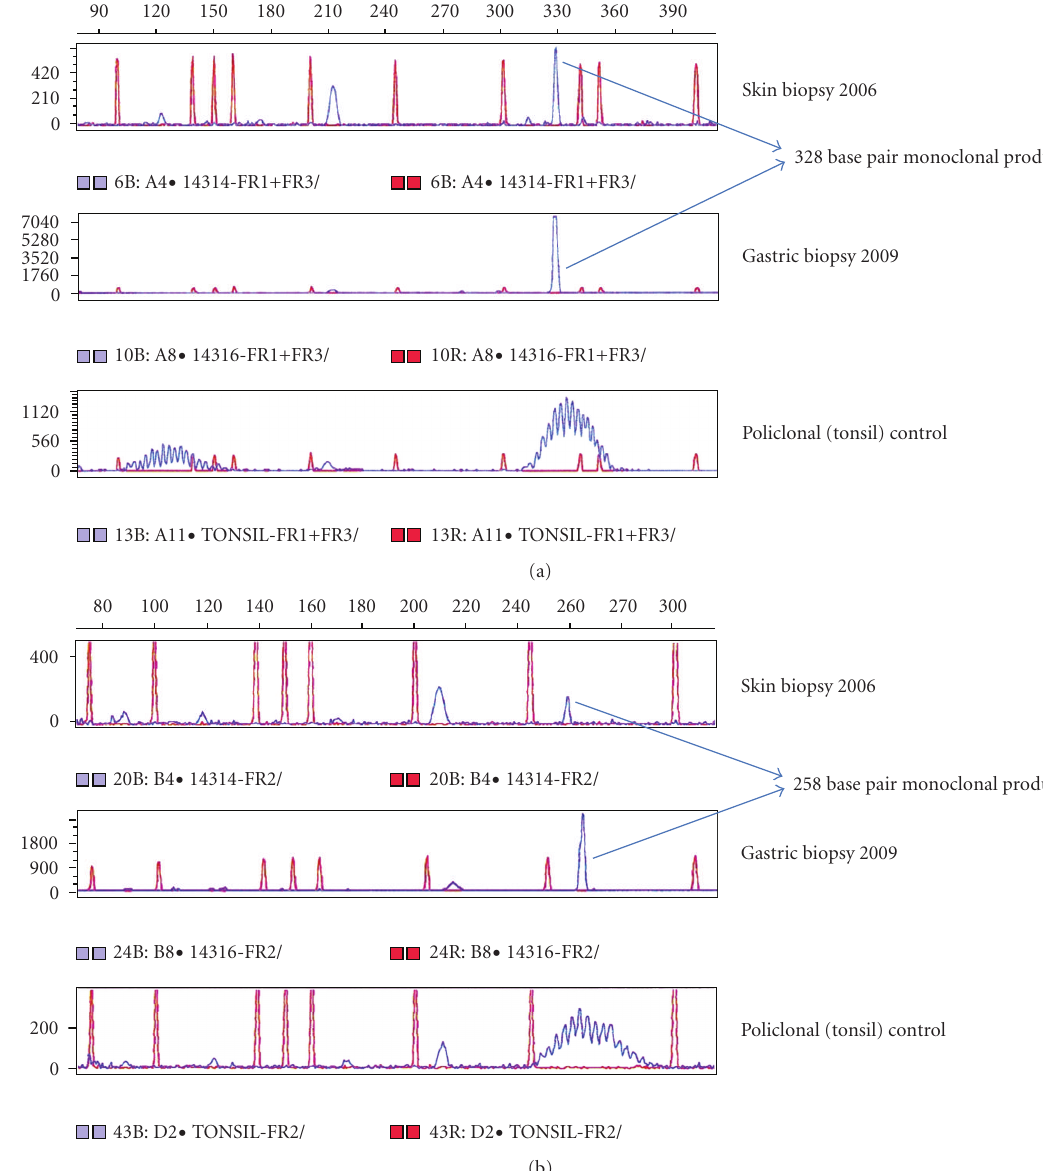
Figure 6: IgH clonality profiles from the PCFCL skin biopsy (2006) and the DLBCL gastric biopsy (2009). GeneScan results obtained using the BIOMED2: (a) FR1 and FR3 and (b) FR2 V H -J H tubes (peaks in blue: patient and control DNA, peaks in red: TAMRA molecular weight marker). The same 328 base pair and 258 base pair monoclonal product is detected in both the skin and gastric biopsies, after FR1 (a) and FR2 (b) PCR amplification, respectively. No PCR product was detected after FR3 amplification (a) probably due to somatic